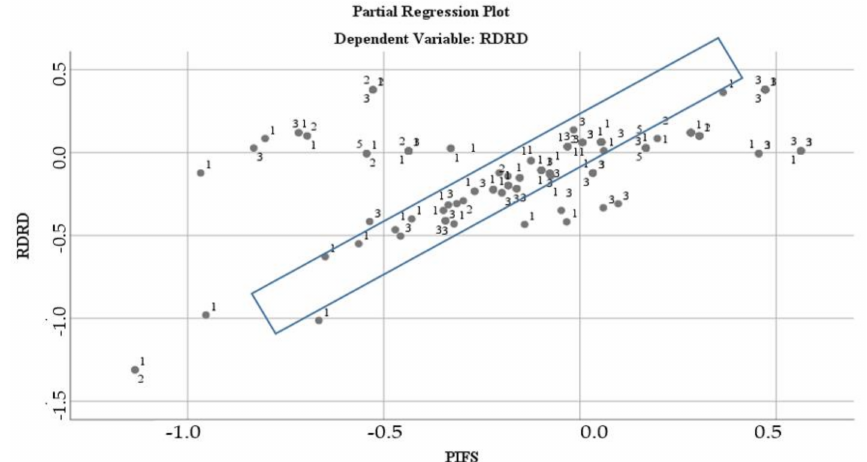
Figure 4. Regression analysis for PIFS.